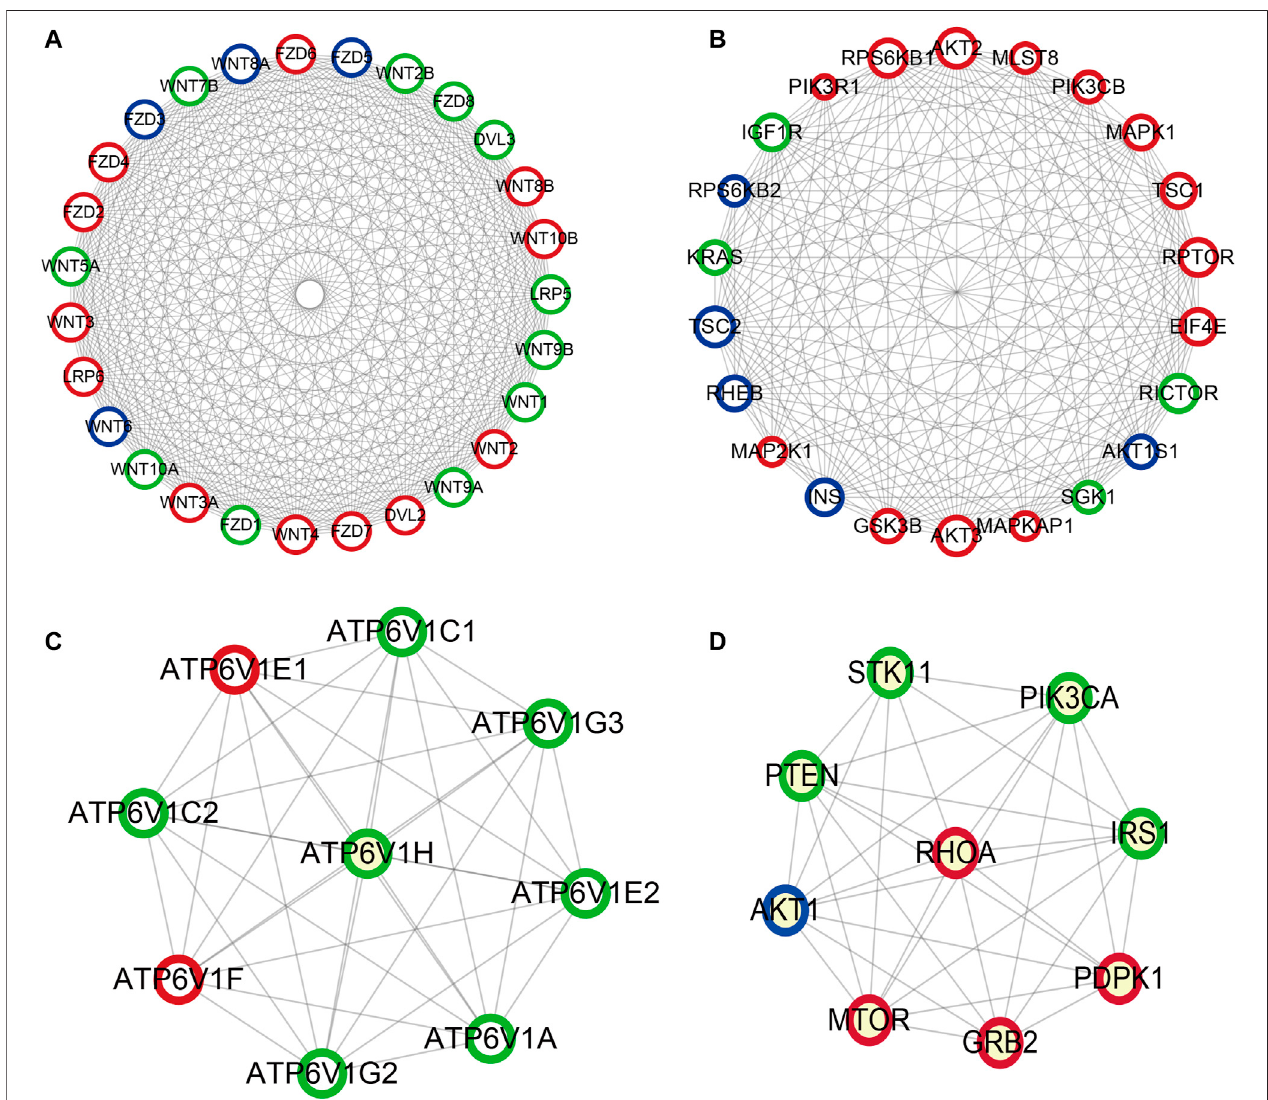
FIGURE 11 | Important modules in PPI network of mTOR signaling pathway (A) module one, (B) module two, (C) module three, (D) module four. Green circles represent miR-96 target genes, blue circles represent miR-99b target genes, the common target genes are in red.